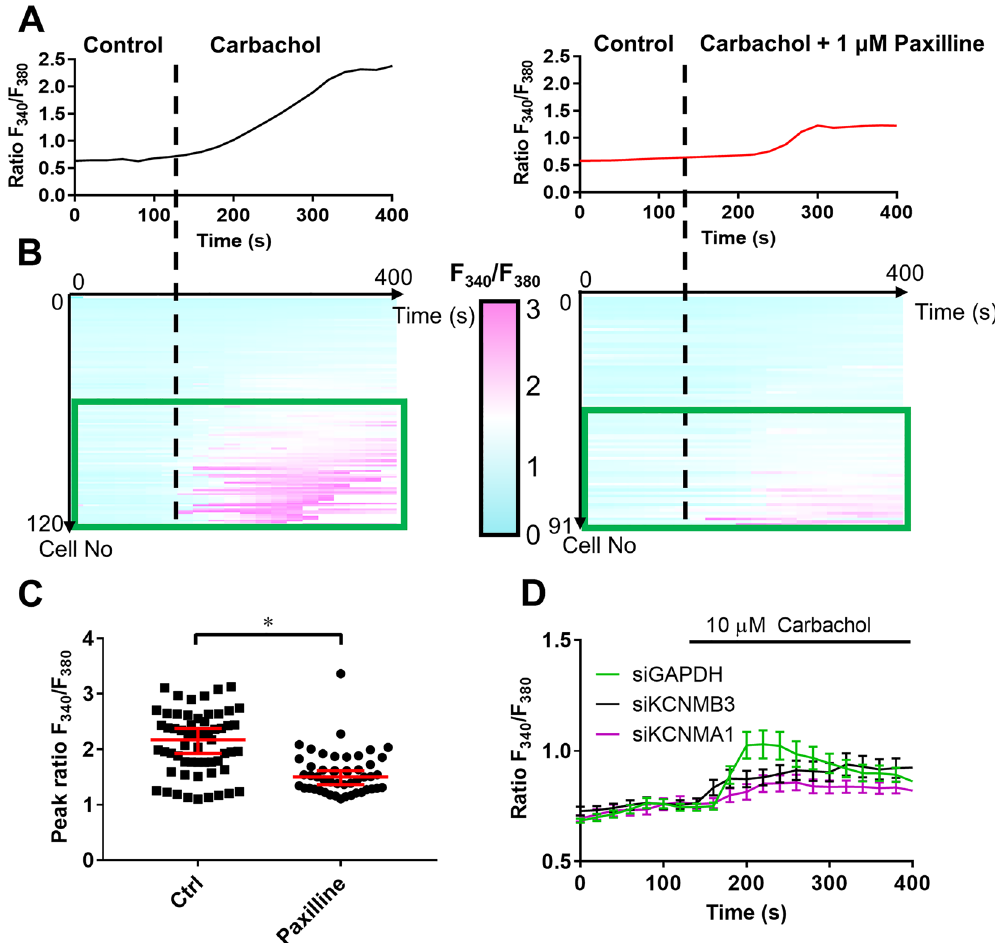
Figure 5. K Ca 1.1 β3 is involved in the Ca 2+ response of U87-MG cells ( A ) Representative intracellular Ca 2+ measurements, F 340 /F 380 ratio reports the intracellular Ca 2+ concentration. Vertical dashed line indicates the beginning of carbachol (10 µM, left, black) or 10 µM carbachol + 1 µM paxilline (right, red) superfusion after a 2 min superfusion with control Ringer’s solution ( B ) Heat map depicting the F 340 /F 380 ratio response as a function of time for each individual cell measured. Left: 10 µM carbachol (N = 5, n = 120); right: 10 µM carbachol + 1 µM paxilline (N = 5, n = 91). Pseudocolor code shows increasing Ca 2+ concentrations with more magenta-toned color. Green rectangle confines cells showing > 20% increase in F 340 /F 380 ratio after carbachol superfusion. ( C ) Peak of the 10 µM carbachol-induced F 340 /F 380 ratio (see A and B for details) of control superfused cells (n = 59, N = 3) and 1 µM paxilline-treated cells (n = 49, N = 3). ( D ) Carbachol- elicited intracellular Ca 2+ response of cells after silencing of GAPDH (green, siGAPDH, N = 3, n = 39, F 340 / F 380 = 1.1 ± 0.06), K Ca 1.1 (purple, siKCNMA1, N = 3, n = 51, F 340 /F 380 = 0.8 ± 0.04) and K Ca 1.1 β3 (black, siKCNMB3, N = 3, n = 30, F 340 /F 380 = 0.9 ± 0.04). In C) and D) data are mean ± SEM for the indicated number